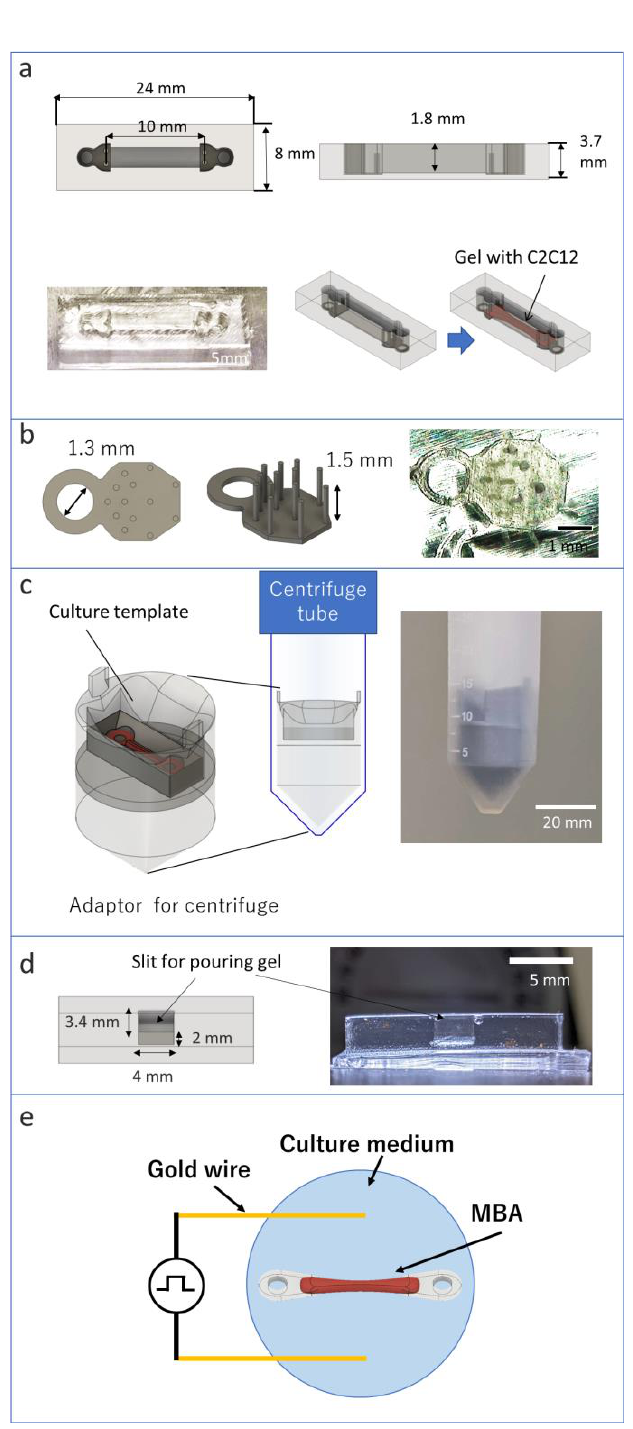
Figure 2. Fabrication of C-MBA’s assembly method: ( a ) culture template, ( b ) tendon structure with some pillars, ( c ) overview of adaptor for centrifuge, ( d ) centrifugal template, ( e ) experimental setup for applying a voltage to the MBA using a gold wire.